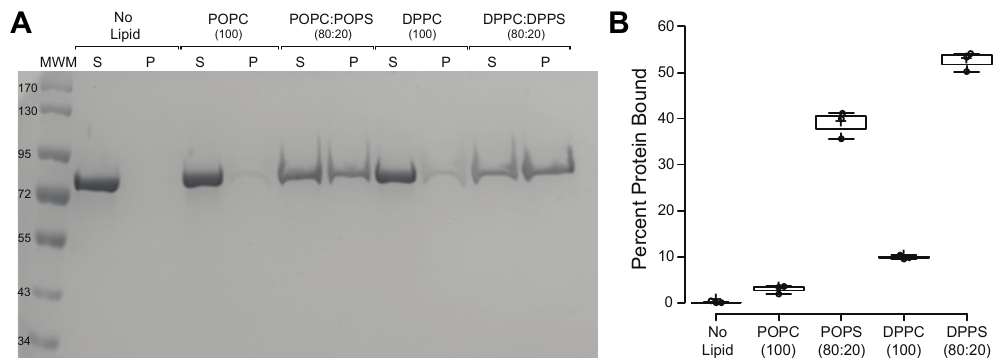
Figure 1. HspA1A binds to liposomes containing phosphatidylserine. A single concentration of liposomes (1 mM total lipid) containing different lipids in a specified molar ratio (see figure) was incubated with 1 μM of protein. After centrifugation of the liposome–protein mixture, the amount of lipid–protein binding was determined by comparing the protein that remained in the supernatant to the protein that was pelleted. ( A ) Representative SDS-PAGE gel electrophoresis of the two fractions (supernatant (S) and pellet (P)) after centrifugation of HspA1A and liposomes composed of different phosphatidylcholine (PC) and phosphatidylserine (PS) lipid species. These gels were overloaded to show protein purity; ( B ) The binding between HspA1A and lipids was quantified and the graphs are expressed as the percentage of protein bound to lipid vesicles ( Y -axis). Error bars represent standard deviations for three independent experiments. The p -values for some of the comparisons were No lipid-POPC, p = 0.308756; No lipid-DPPC, p = 0.000308; POPS-DPPS, p = 0.000153.